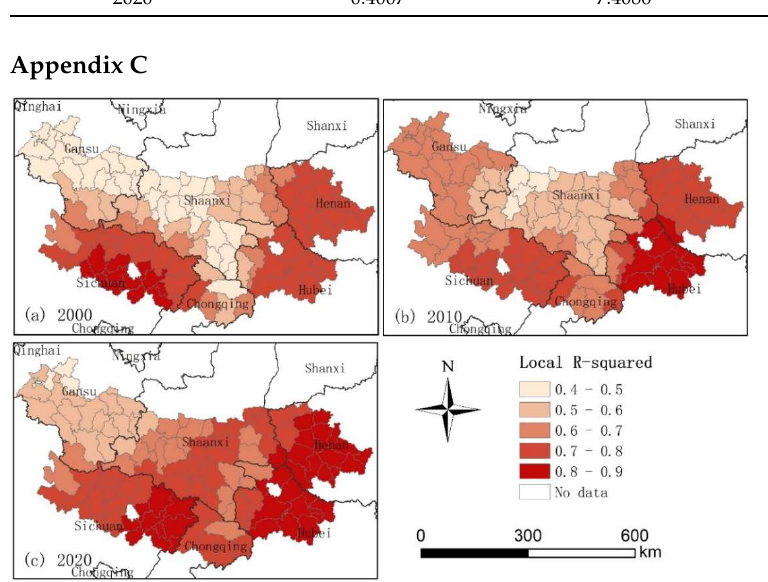
Figure A2. Spatial mapping of the locally weighted coefficient of determination (R2) between the observed and fitted values is performed by GWR modeling at the county level.